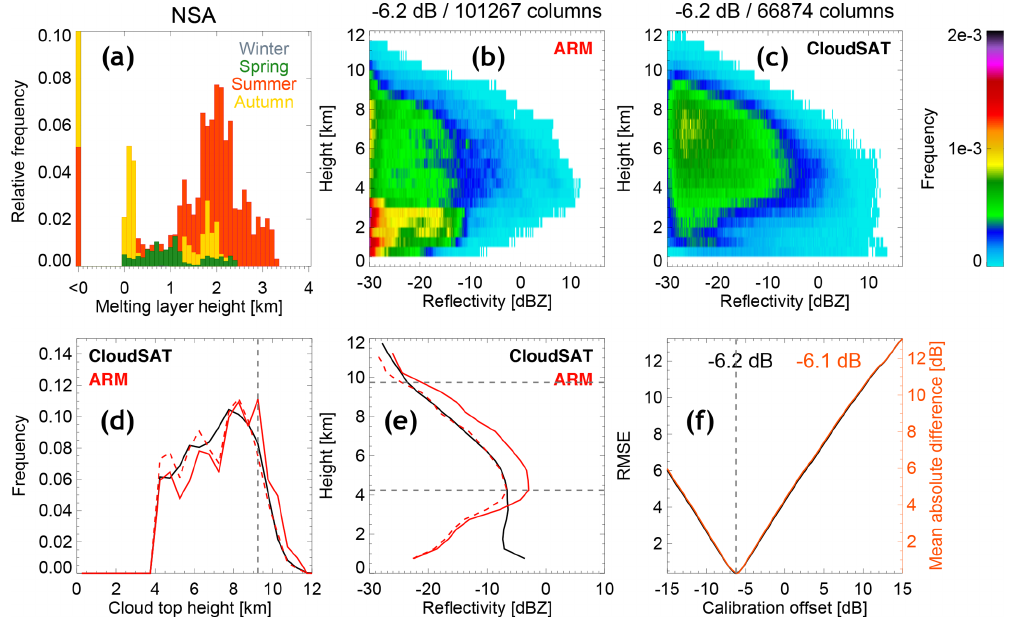
Figure 4. Example of the CloudSat–ARM radar calibration at the NSA for mode 2 of the MMCR for the period January 2008 to Decem- ber 2009. (a) the seasonal distribution of the melting layer heights, (b) the distribution with height of the ARM radar reflectivities, (c) the distribution with height of the CloudSat radar reflectivities, (d) the comparison of the CloudSat (black) and ARM (red) cloud top height histograms. The solid red line indicates the cloud top height distribution from the archived ARM radar data and the dashed red line indicates the cloud top height distribution after 6.2dB is subtracted by the ARM radar reflectivities, (e) the comparison of the CloudSat (black) and ARM (red) mean radar reflectivity profiles. The solid red line indicates the ARM mean radar reflectivity profile using the archived ARM radar data and the dashed red line indicates the ARM radar reflectivity profile after 6.2dB is subtracted by the ARM radar reflectivities, (f) the RMSE value between the radar reflectivity profiles for different calibration